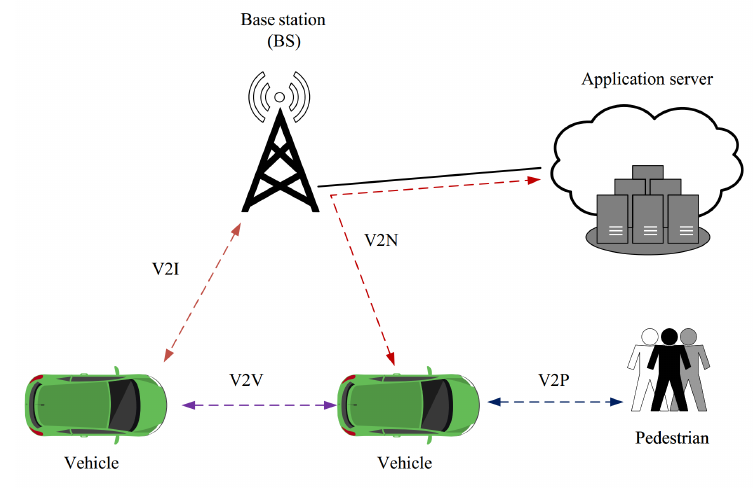
Figure 1. Vehicular ad hoc networks